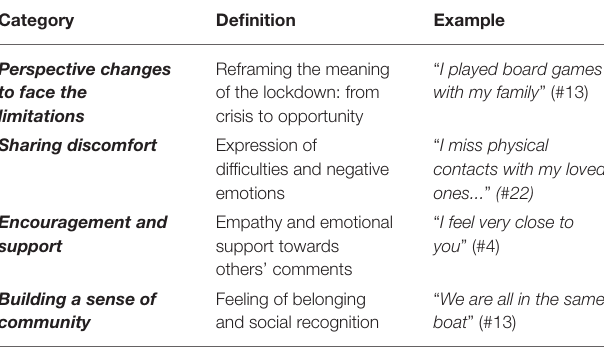
TABLE 1 | Categories from the analysis of the interactions. Category